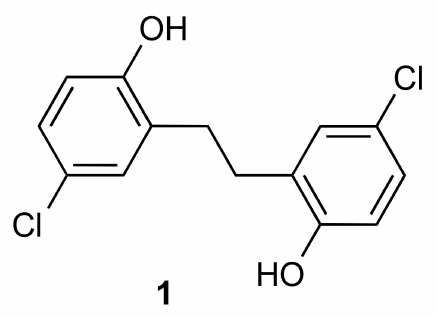
Figure 1. Structure of the title compound 1